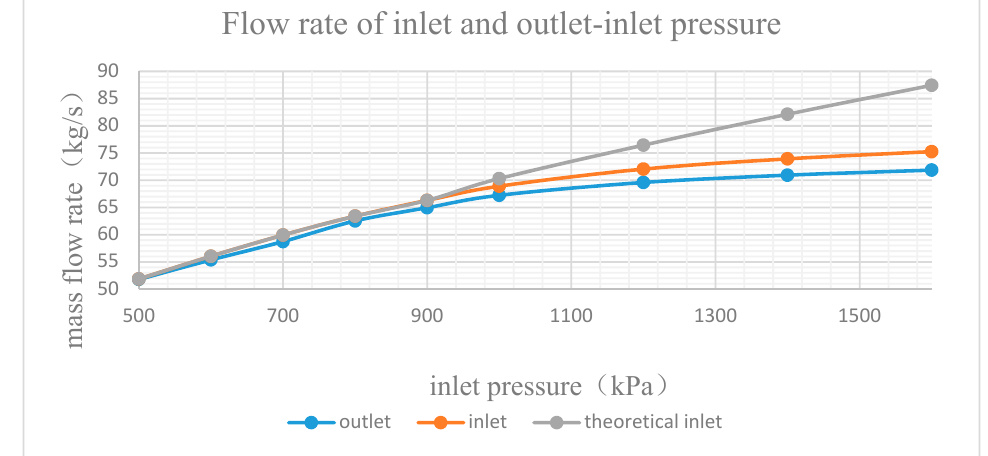
Figure 15. With the increase of inlet pressure, the inlet flow rate and outlet flow rate increase almost linearly, but when the inlet pressure p in increases to more than 900 kPa, the increase of outlet flow rate slows down, resulting in a larger flow loss.